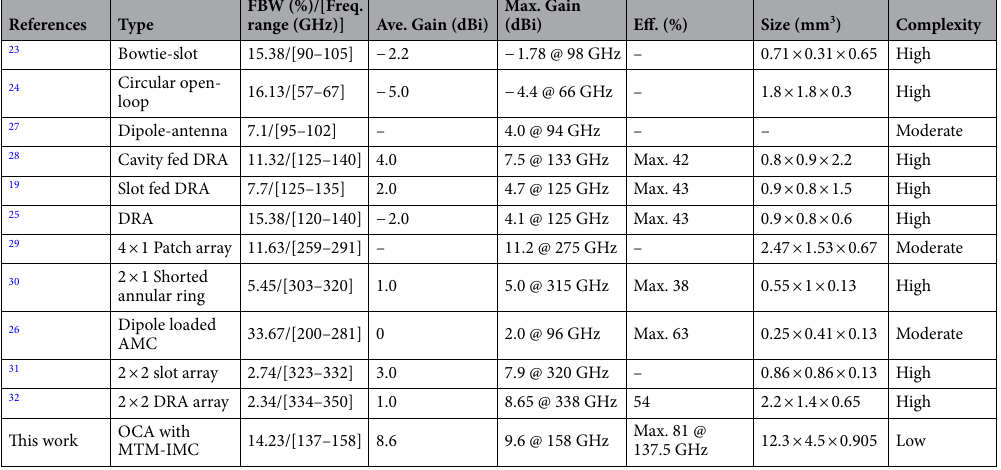
Table 3. Performance